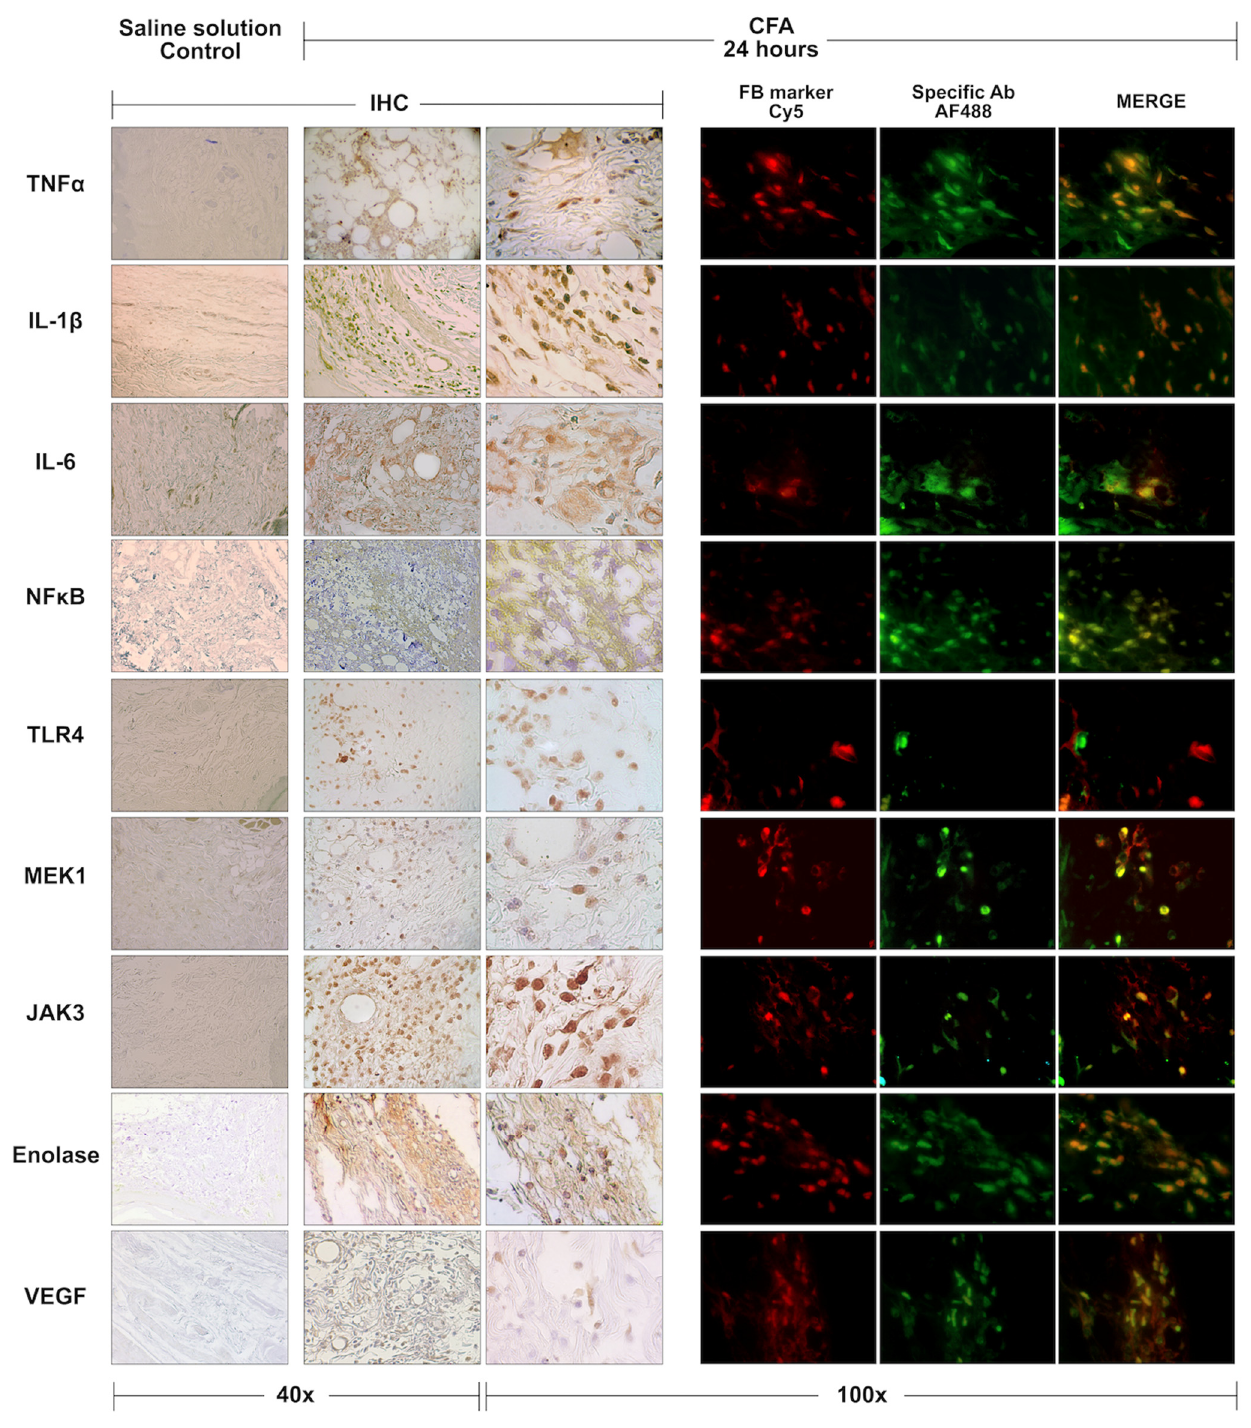
Figure 5. Immunodetection of Rheumatoid Arthritis related proteins in the rats’ footpads at 24 h post-Complete Freund’s adjuvant injection. TNF- α , IL-1 β , IL-6, NF κ B, TLR4, MEK1, JAK3, Eno, and VEGF proteins were identified in tissues using immunohistochemistry staining and photographed at 40× and 100× magnifications to observe tissue and cell positive detections. Double immunofluorescence was performed to co-localize these proteins (green) in the fibroblasts (ER-TR7; red). Moreover, the expression of CDH11 and ColVI, molecules associated with the path- ogenic phenotype of FLS, were overexpressed in the cells from the CFA-injection site at 24 h (Figure 6). In the case of CDH11, an increased number of cells expressing it was noted